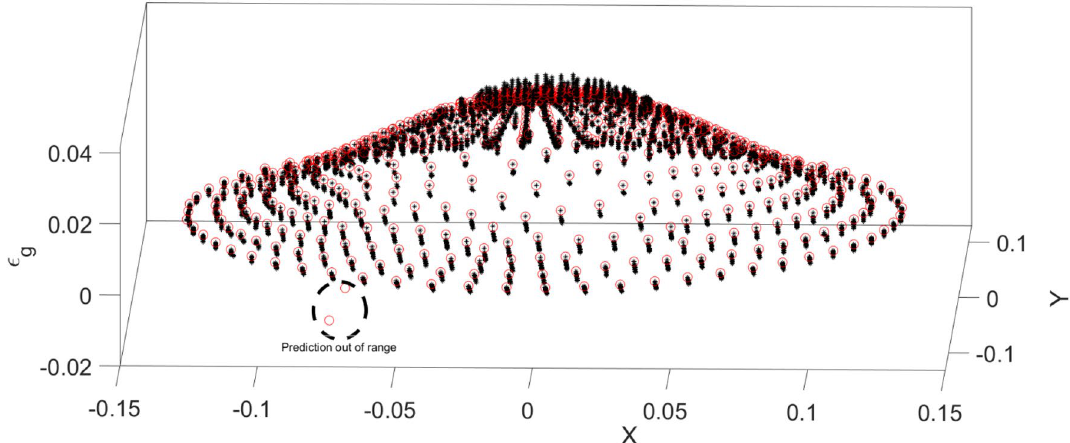
Figure 8. Prediction of gas hold-up with ANFIS method and compared with CFD results at the top surface of the